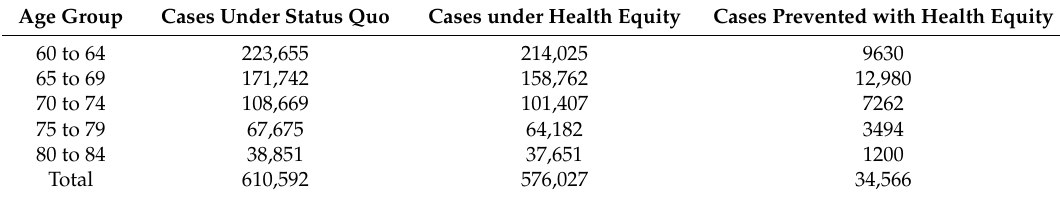
Table 2. Potential herpes zoster cases prevented in elderly blacks by achieving health equity in shingles vaccine